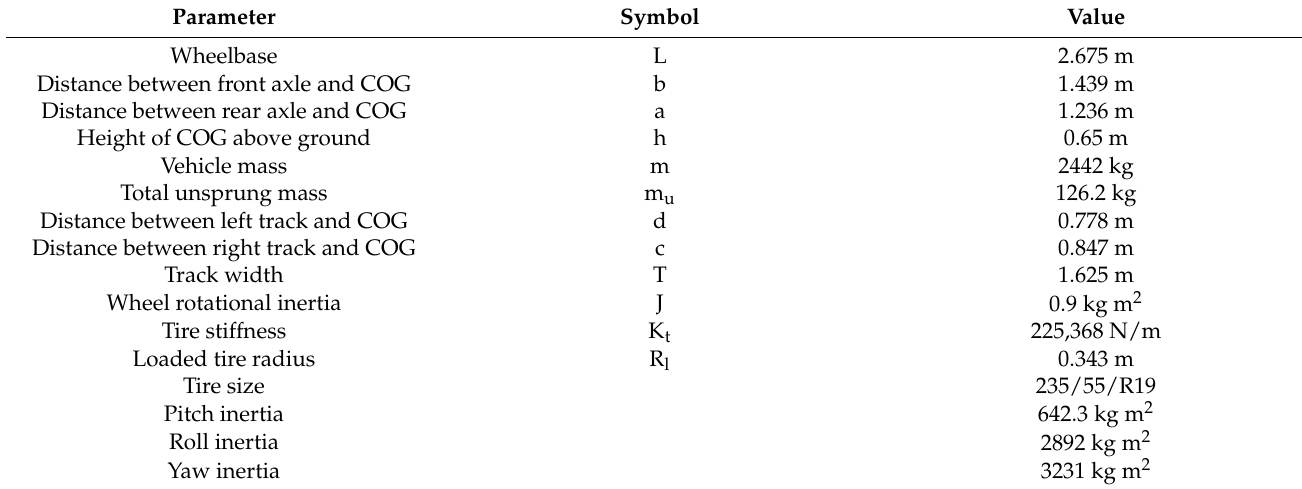
Table 1 . Data used in mathematical model